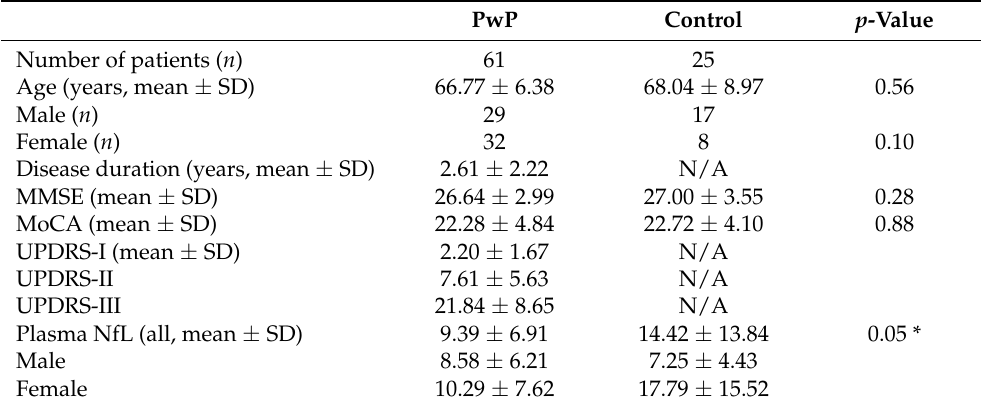
Table 1. Demographic data of the SHH